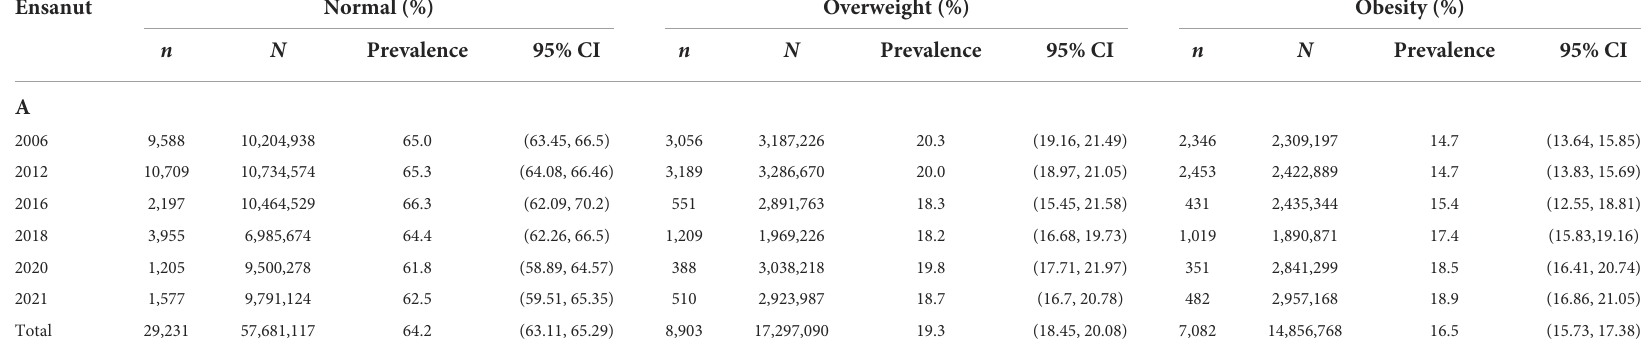
TABLE 2 Prevalence of nutritional conditions (A) proportion of consumer of food groups and intake of total energy and fiber (B), total energy and fiber for each temporary follow-up group. Ensanut Normal